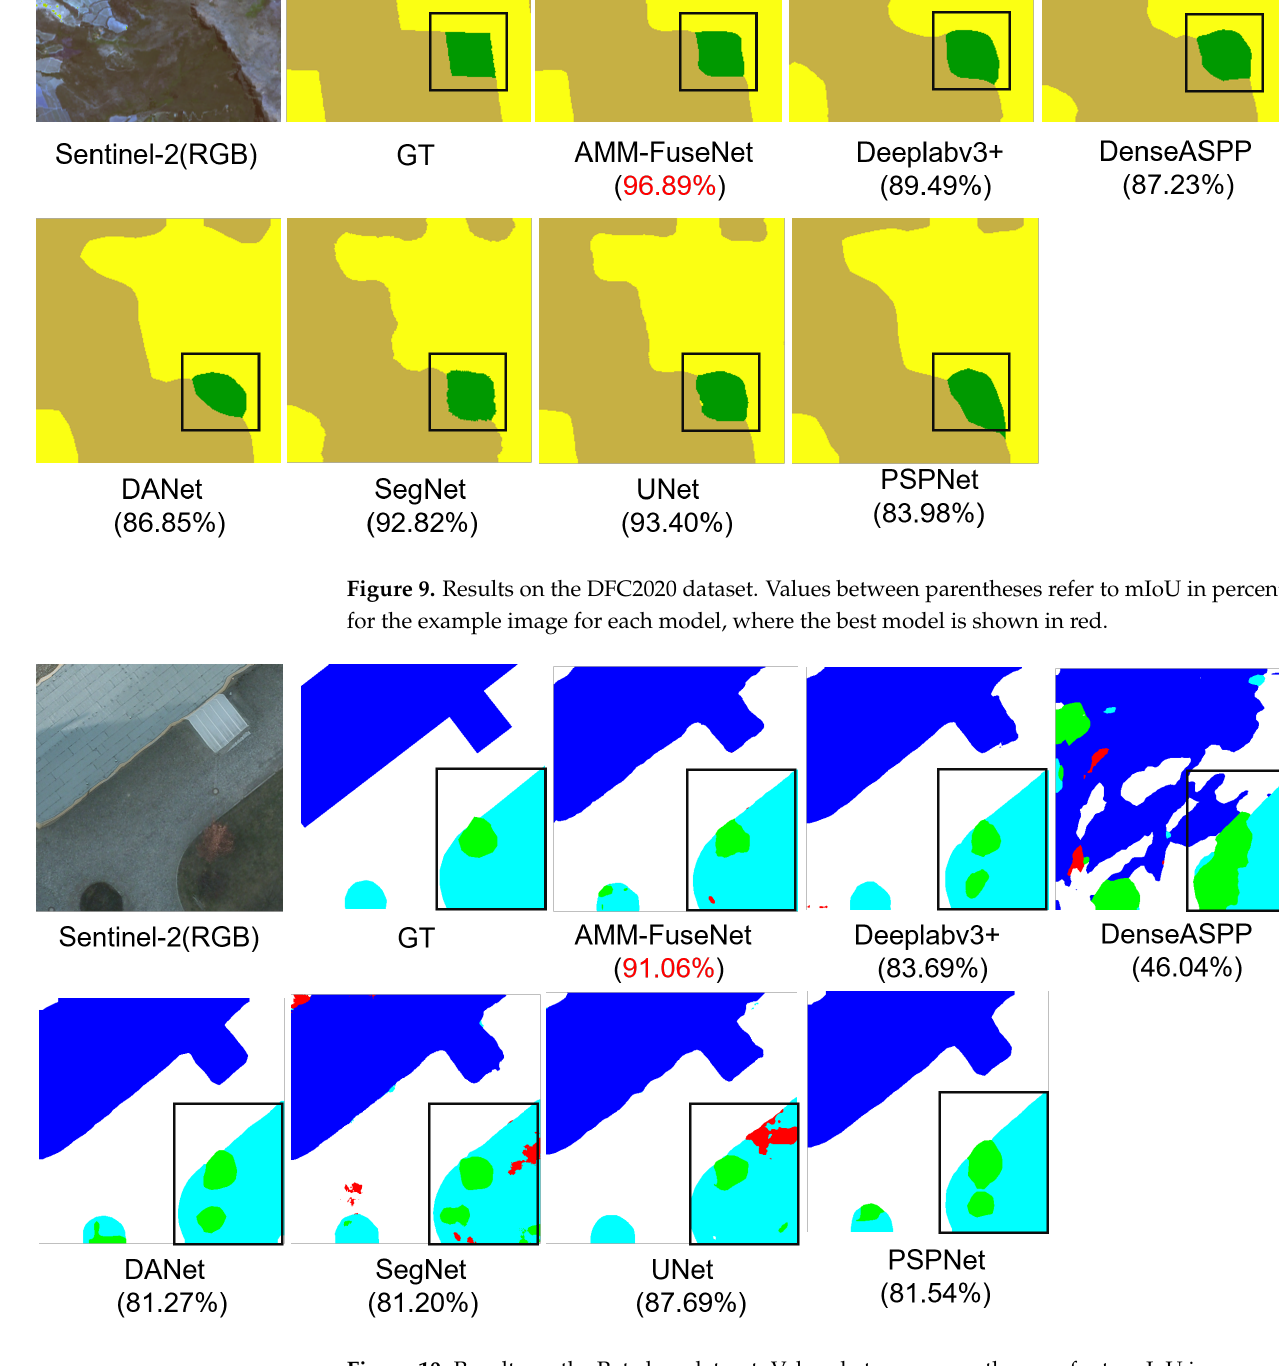
Figure 10. Results on the Potsdam dataset. Values between parentheses refer to mIoU in percentages for the example image for each model, where the best model is shown in